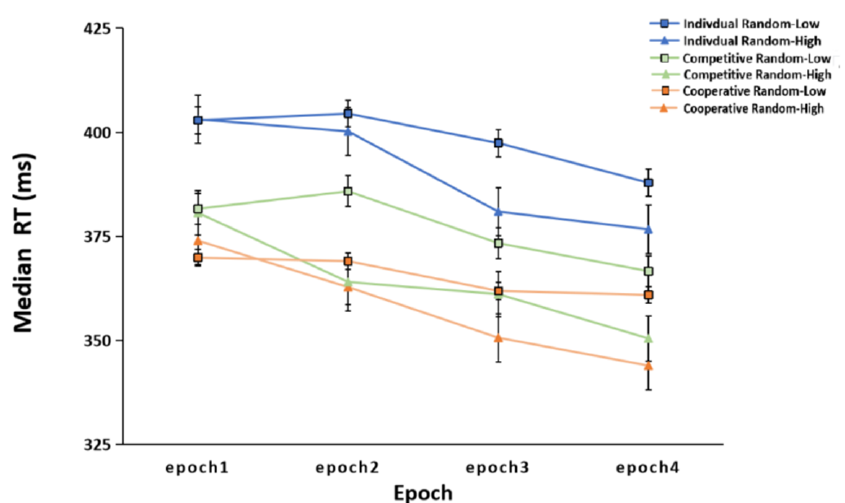
Figure 5. Median reaction times (RTs) of random low-frequency triplets and random high-frequency triplets in the individual group, cooperative group, and competitive group, across the learning process (epochs 1–4). The error bars indicate the standard error.